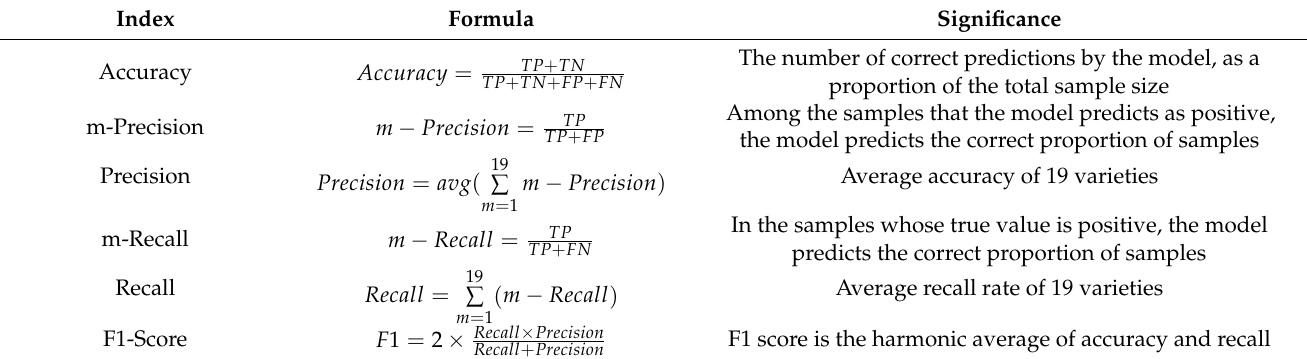
Table 5. Calculation formulas of each